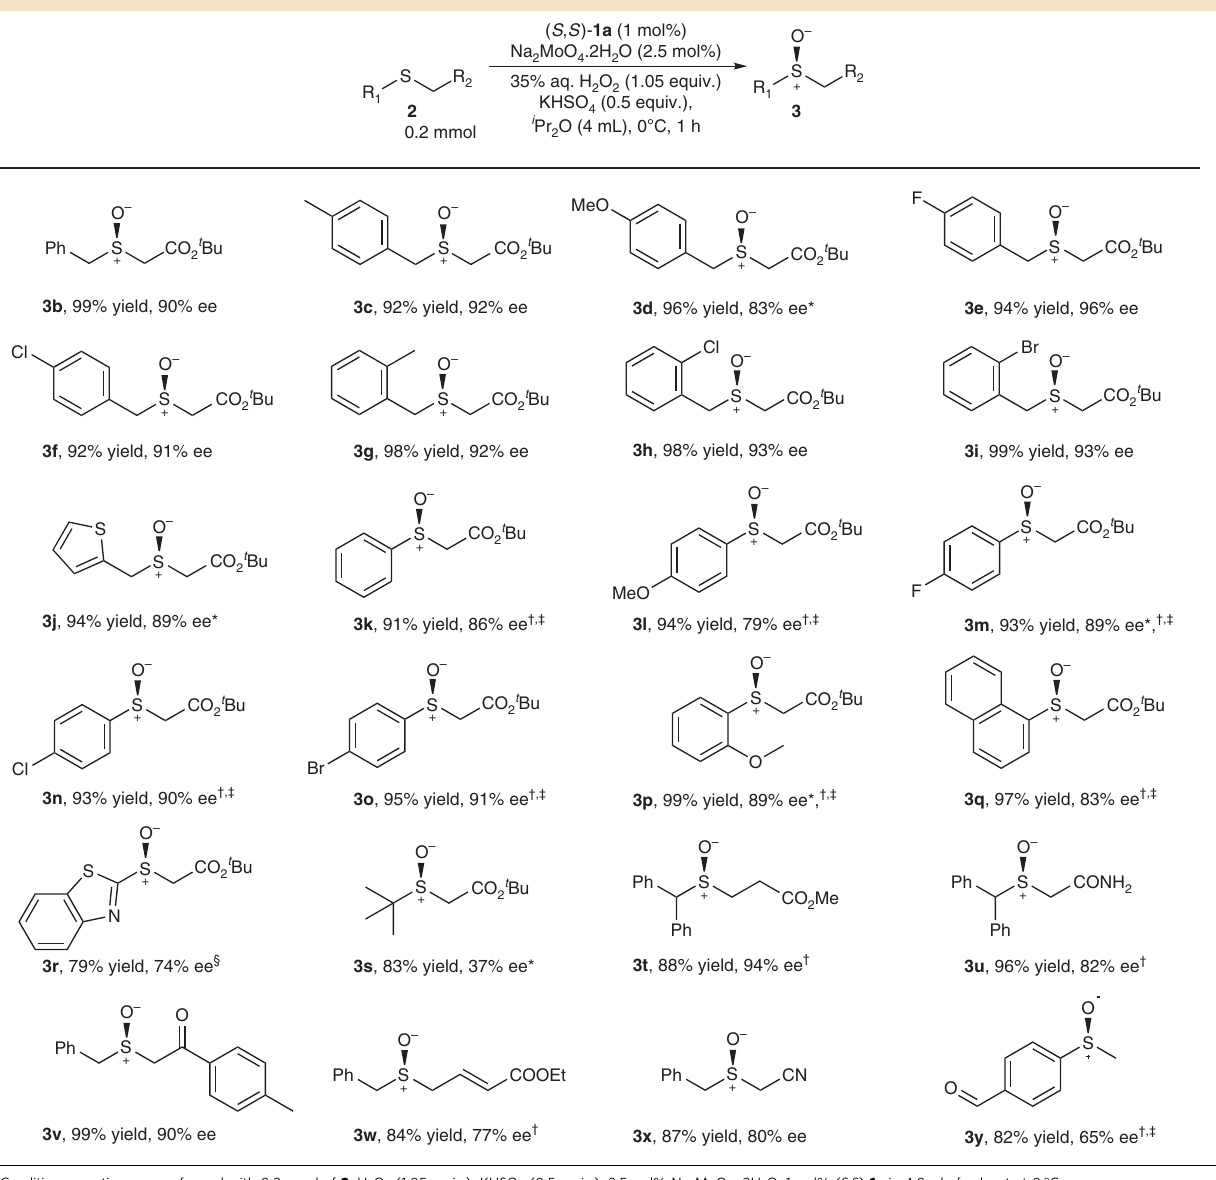
Table 2 | Substrate scope of sulfides in asymmetric